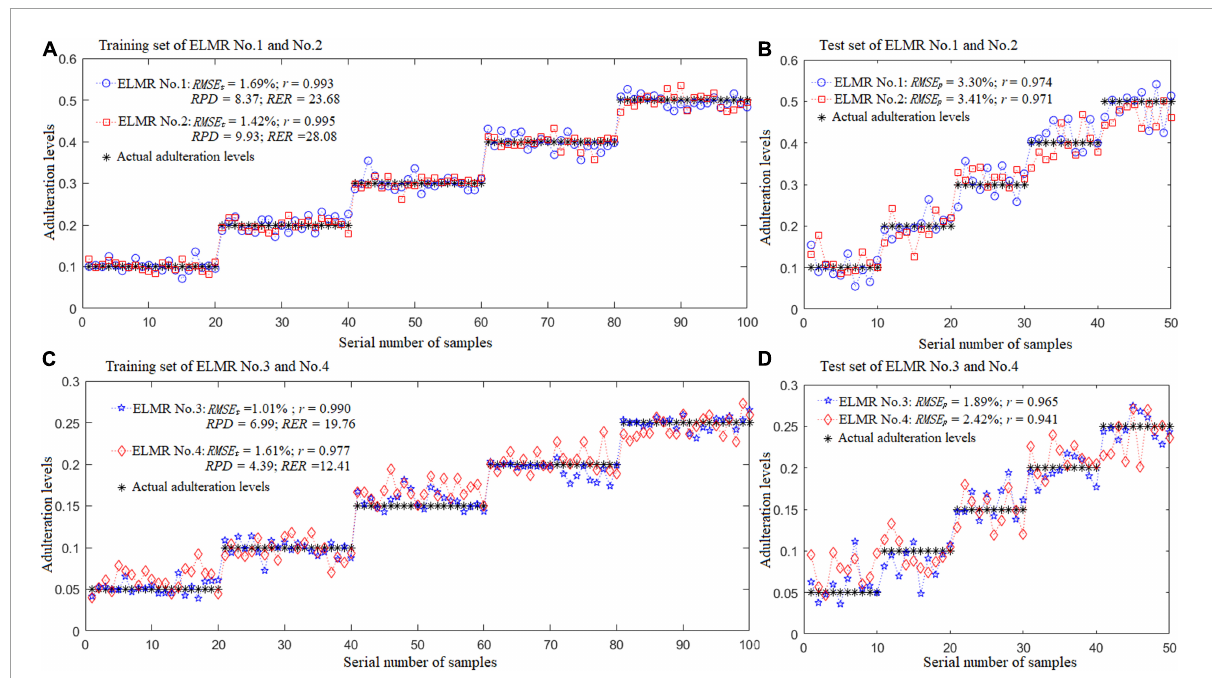
FIGURE8 Results of the optimal ELMR models for predicting adulteration levels. (A,B) ELMR No. 1 for prediction of the CBG content in DBT adulterated with CBG; ELMR No. 2 for prediction of the PBG content in DBT adulterated with PBG; and (C,D) ELMR Nos. 3 and 4 for prediction of the CBG and PBG content in the DBT ternary mixed with cow and pig blood-based gels,